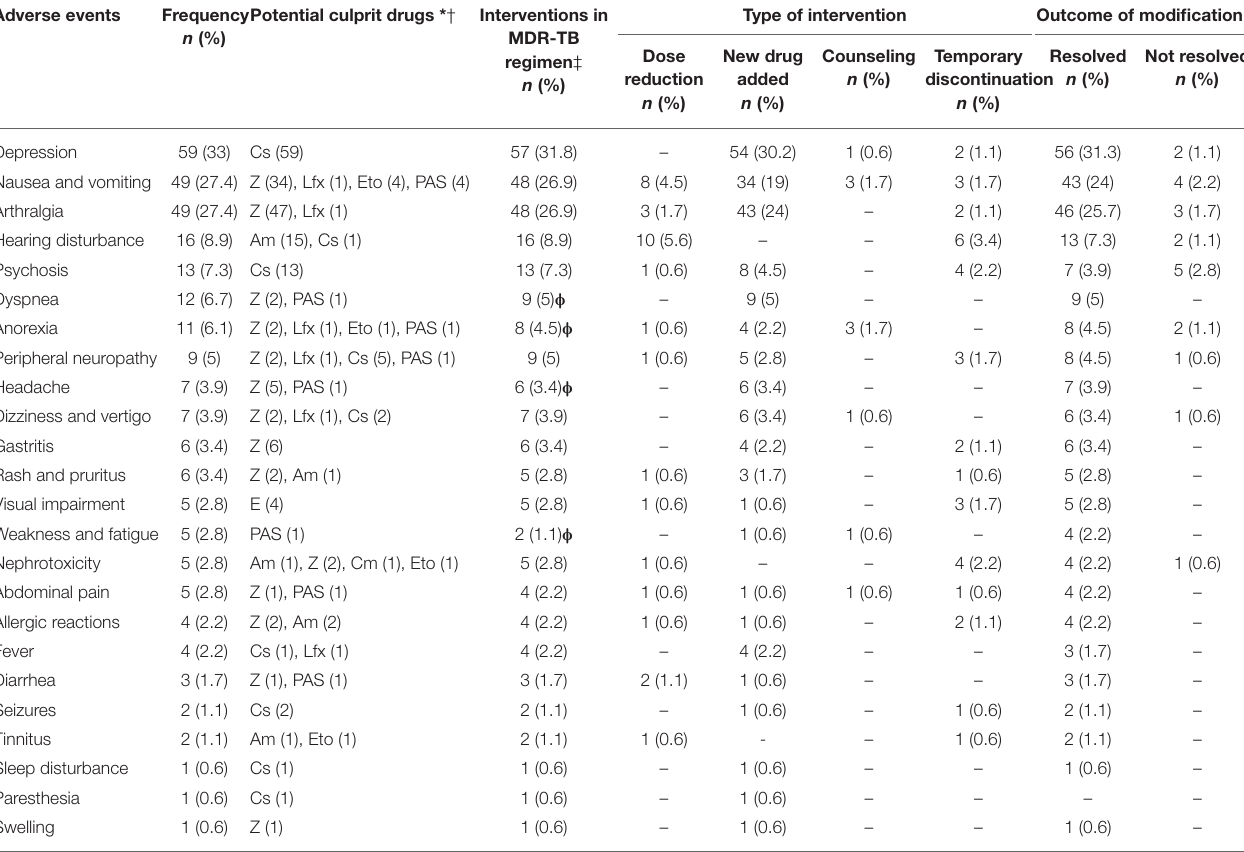
TABLE 4 | Type of adverse events recorded and the management strategy. Adverse